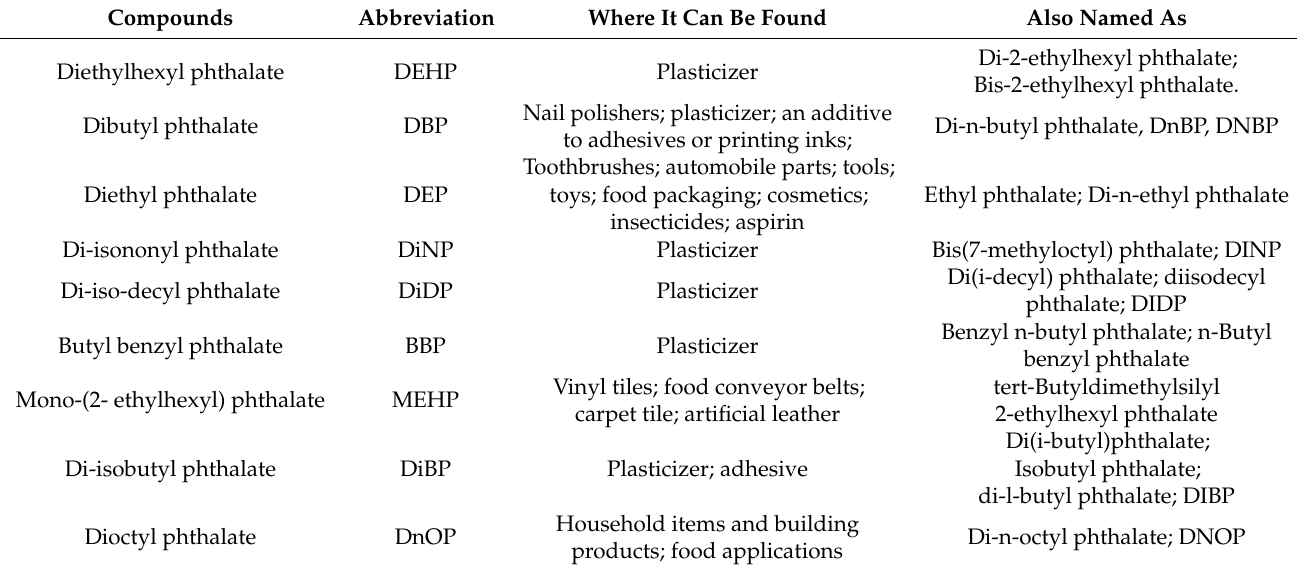
Table 1. Common phthalate